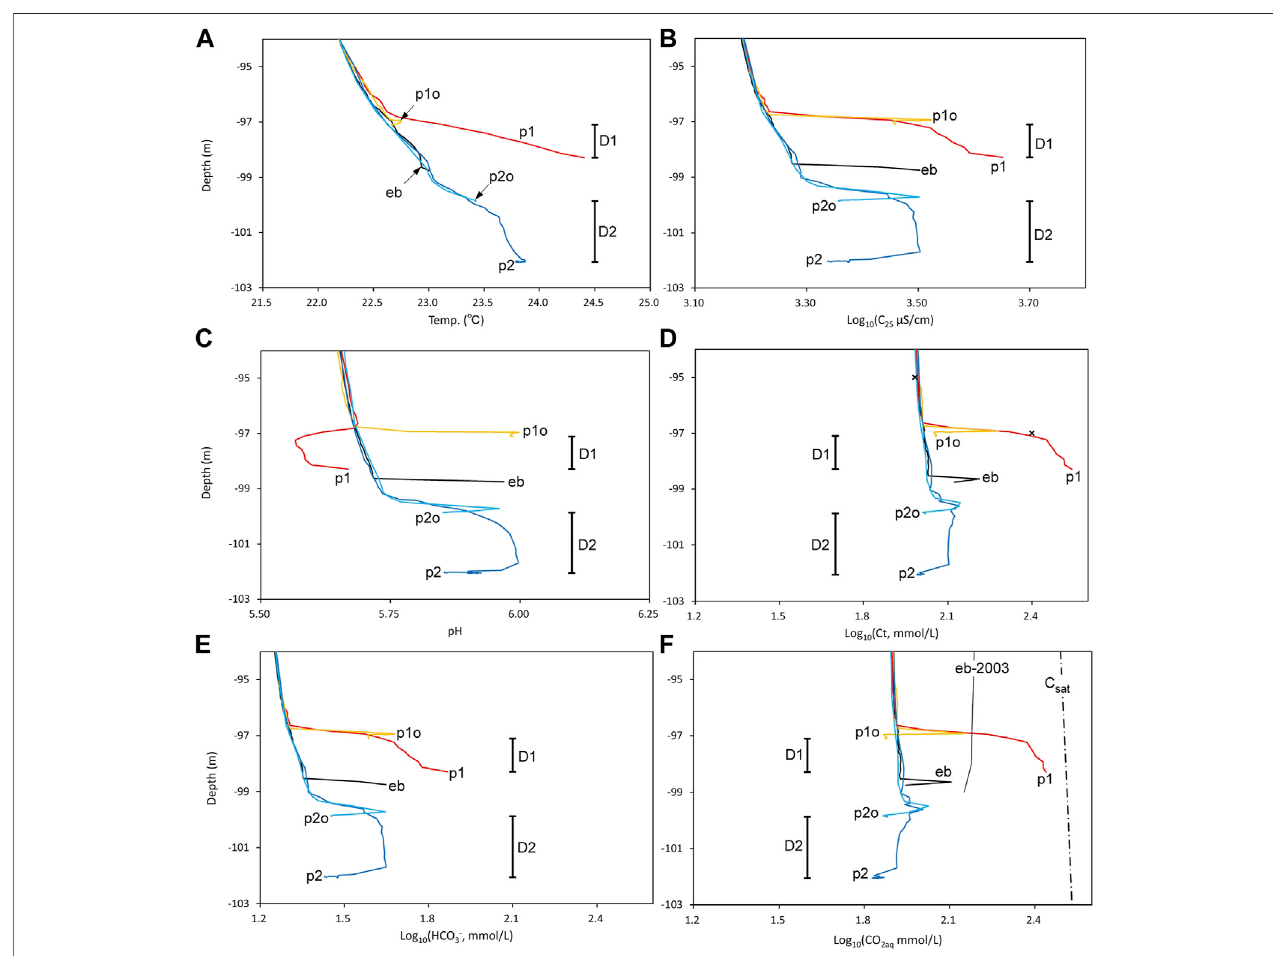
FIGURE6| Pro fi lesbelow − 94 mdepthinEB. (A) Temperature, (B) Log(C 25 µS/cm), (C) pH, (D) Log(Ctmmol/L), (E) Log([HCO 3 ‾ ]mmol/L), and (F) Log([CO 2aq ] mmol/L).VerticalbarsindicatetherangesofdepthinsideD1andD2.In (F)